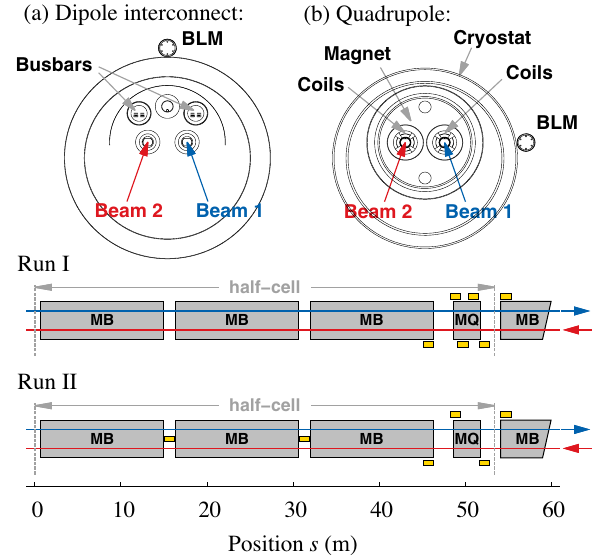
FIG. 2. Illustration of BLM positions in a standard LHC arc half-cell. The two layout plots at the bottom show a top view of the different BLM positions in run I and run II, respectively. Gray boxes represent magnets (bending dipoles: MB, quadrupoles: MQ), yellow boxes represent monitors. Monitors around the quadrupole are located on the horizontal plane (figure top right), while monitors between dipoles (run II only) are located on top of the dipole interconnects (figure top left). The blue and red arrows indicate the beam direction of beam 1 and beam 2,